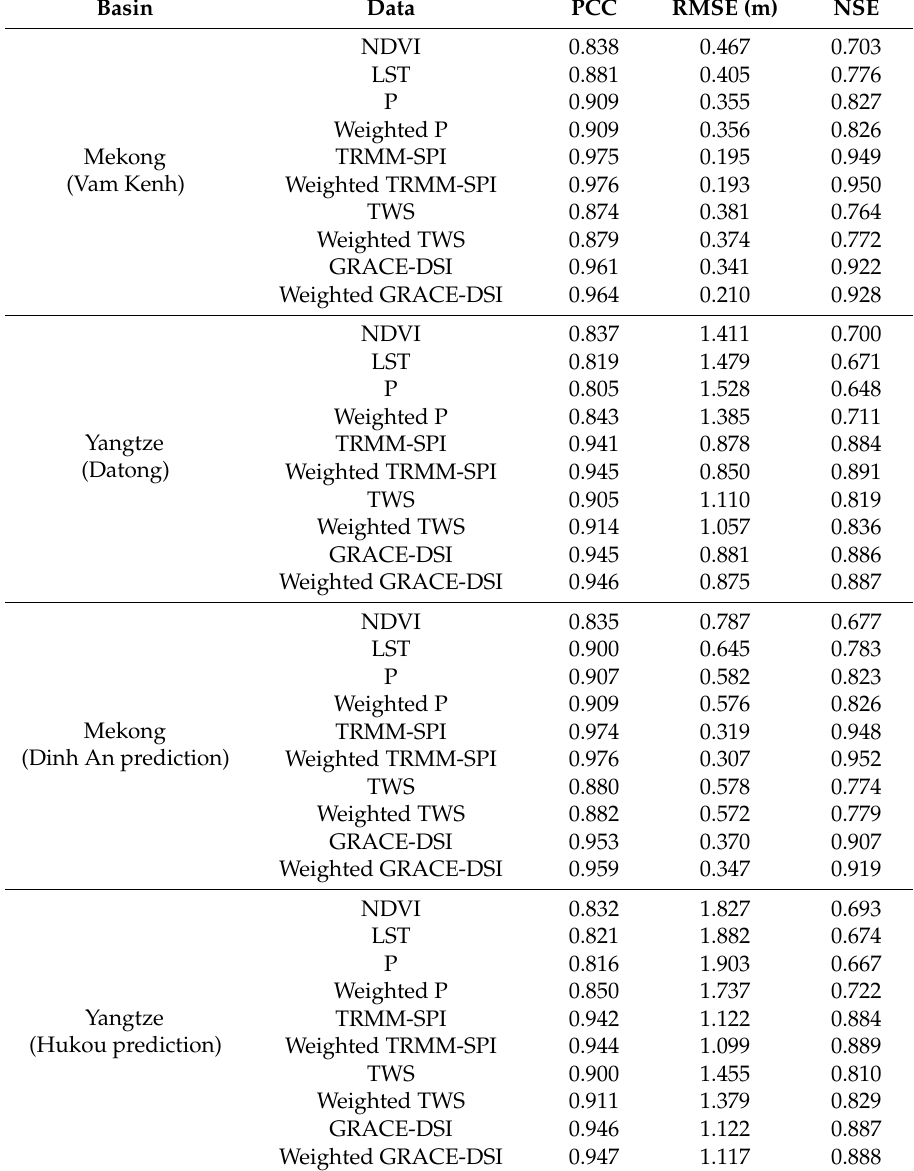
Table 1. Performance of the reconstructed water level from different indices at Vam Kenh (Datong) station in the MRB (YRB) and the predicted water level at Dinh An (Hukou) station in the MRB (YRB), respectively, against the observed water level. The predictions for Dinh An in the MRB and for Hukou in the YRB serve as the external assessment. The Dinh An (Hukou) prediction means the WL of Dinh An (Hukou) was predicted based on the reconstructed relationships between the WL from the Vam Kenh (Datong) station and abovementioned